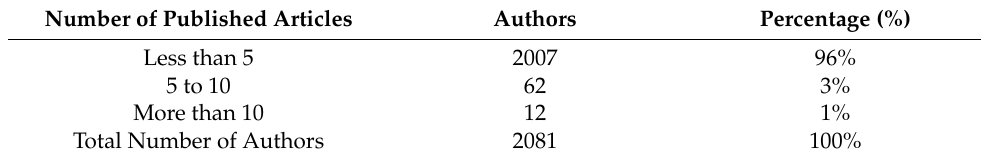
Table 3. Number of authors in respect to the number of published articles.